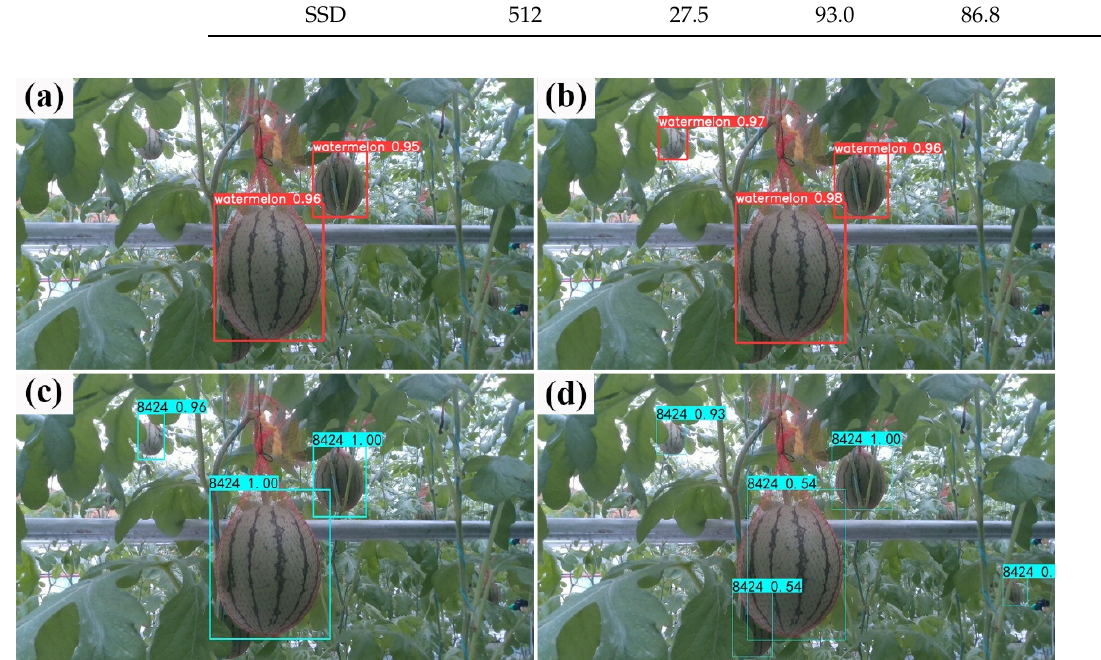
Figure 13. Inference results of different detectors: ( a ) YOLOv5s–CBAM; ( b ) YOLOv5s; ( c ) YOLOv4; ( d ) SSD.